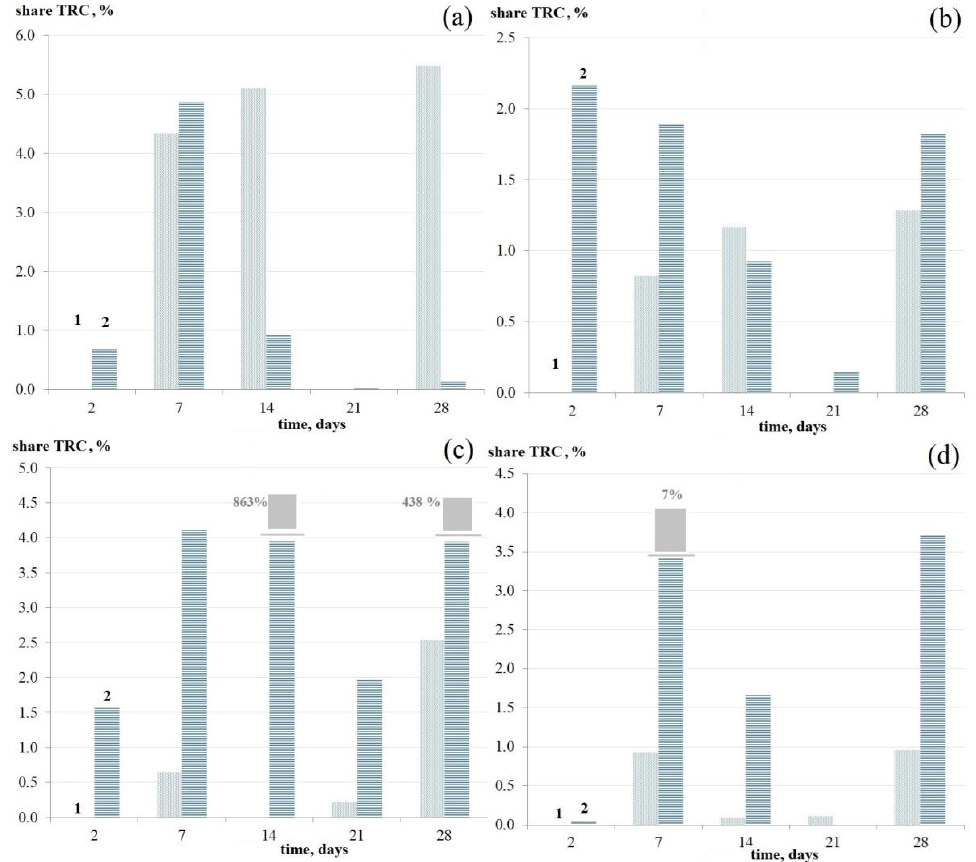
Figure 6. Dynamics of changes in the proportion (%) of thermoresistant cells in the biofilms (1) and planktonic cultures (2) of bacteria: E. coli ( a ), S. typhimurium ( b ), P. aeruginosa ( c ) and S. aureus ( d ) during 28-day incubation.